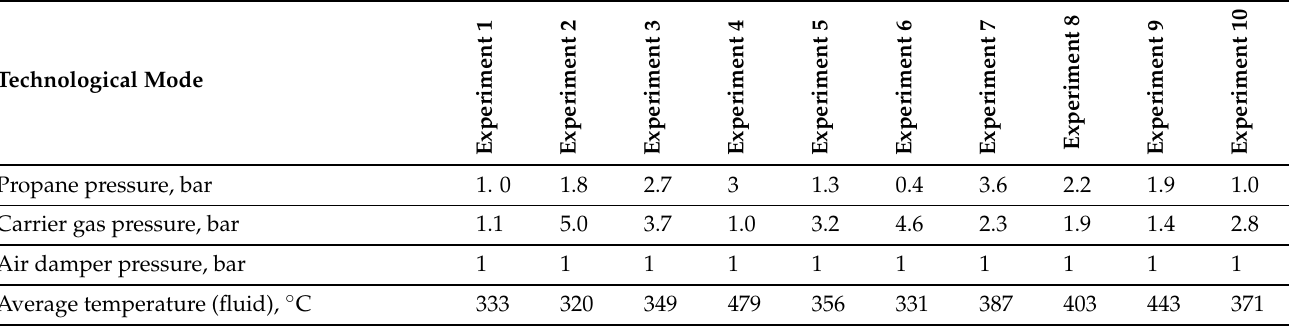
Figure 5. Influences of variable technological parameters on the flame’s temperature along the central axis of the flame. Table 2. Dependence of the pressure of the transporting gas and the residence time of the particle in the body of the